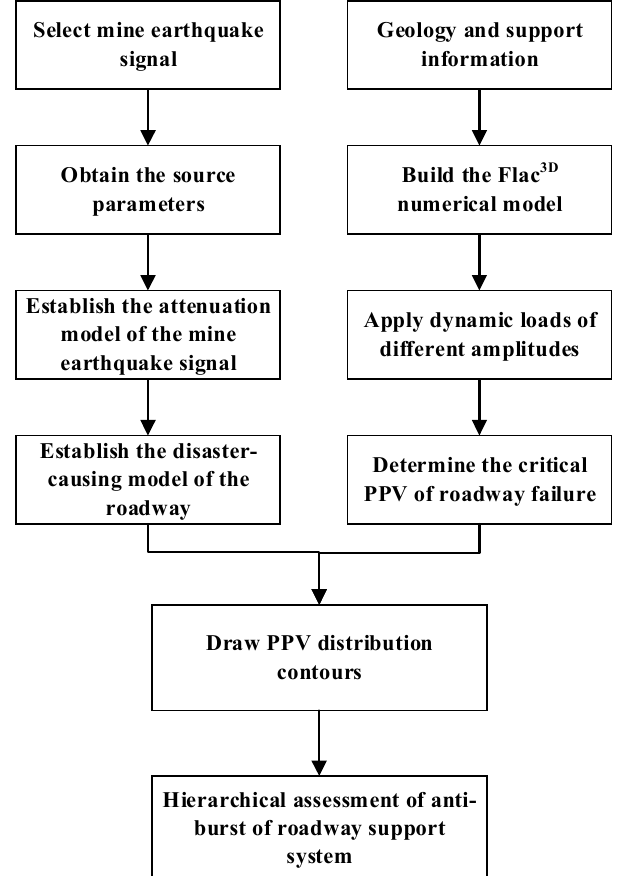
Figure 1. Process diagram of anti-burst performance evaluation for roadways.